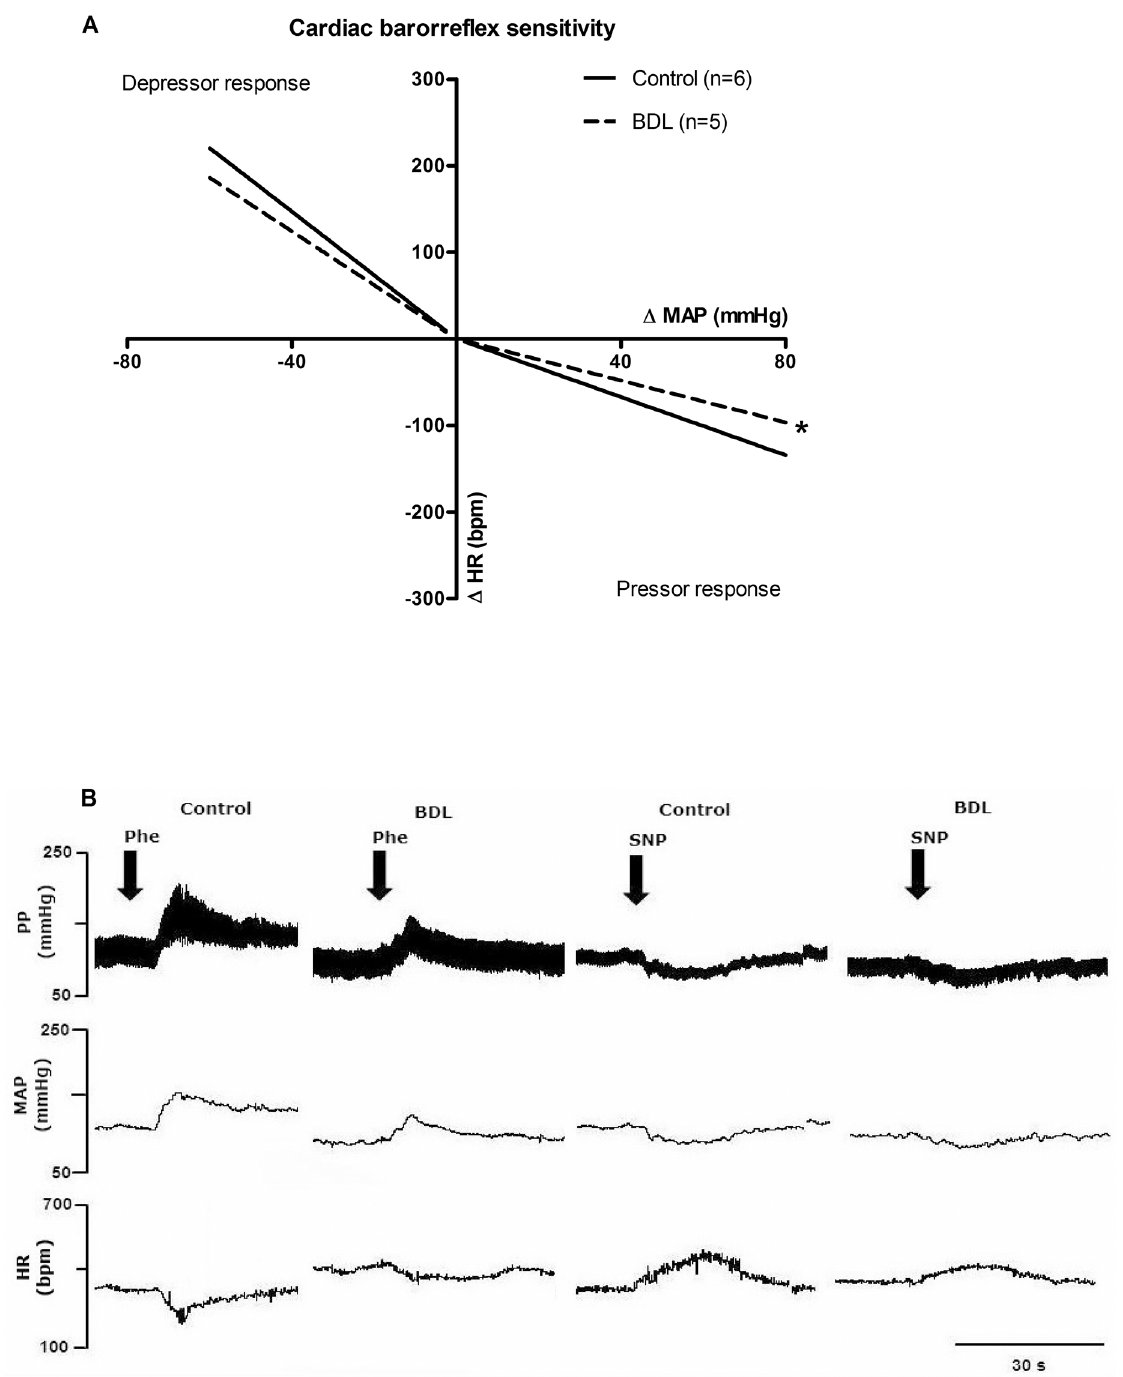
Fig 1. Baroreceptor reflex sensitivity for heart rate (HR). ( A ) Linear regression graph showing: depressor response — the reflexive increase in heart rate ( Δ HR) to decrease the mean arterial pressure ( Δ MAP) produced by acute administration of sodium nitroprusside (7, 17, and 20 μ g/kg); and pressor response — HR decrease reflex response to increase MAP produced by acute administration of phenylephrine (3, 6, and 10 μ g/kg) in the control and bile duction ligation (BDL) groups. n, number of rats. * P < 0.05 compared to control group (Sutdent ’ t test). ( B ) Representative recording of cardiovascular responses induced by acute infusion of phenylephrine (Phe) and sodium nitroprusside (SNP) in the control and BDL groups. Pulse pressure (PP), heart rate (HR), beats per minute (bpm) and mean arterial pressure (MAP).